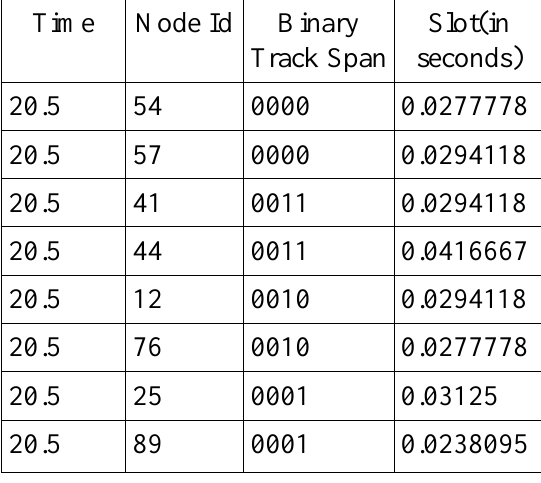
Table 1.b Slot Allocation table at the various time